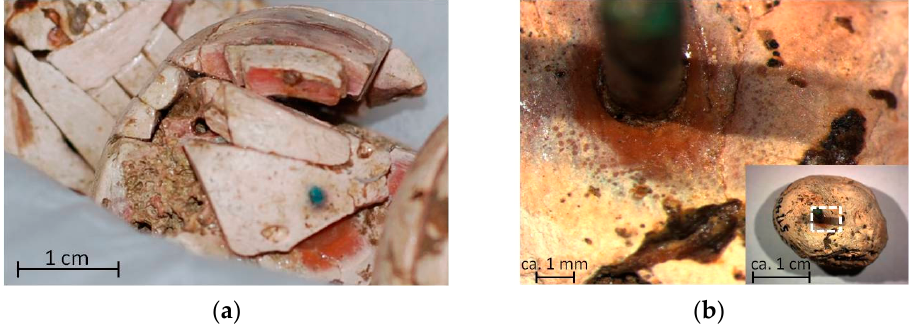
Figure 4. ( a ) Detail of the almost egg-sized coral bead from the female burial of Esslingen-Sirnau; see Figure 2d; ( b ) detail of another almost egg-sized coral bead from Ditzingen-Schöckingen, where a small red part around the bronze pin is visible.